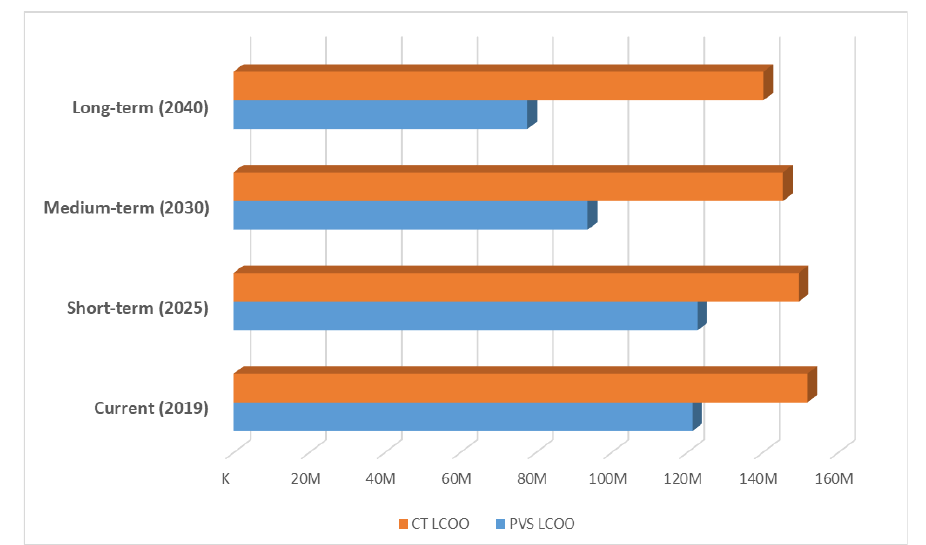
Figure 14. Future LCOO comparison between PVS and Combustion Turbine (CT) based on Li-Ion BESS cost reductions, natural gas price reduction and ITC ramp down.